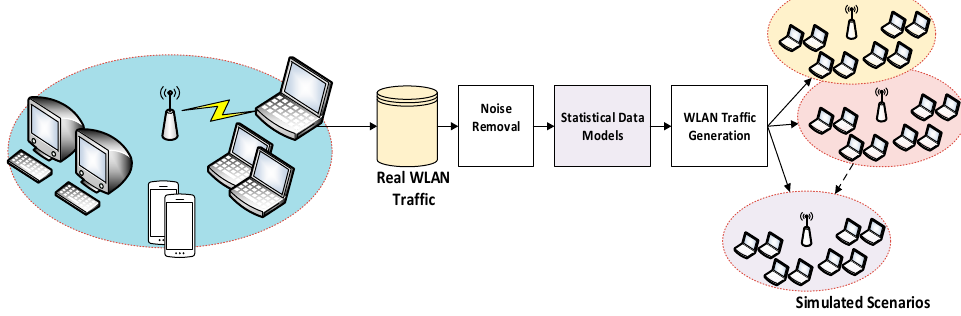
Figure 3. Capturing and simulating WLAN